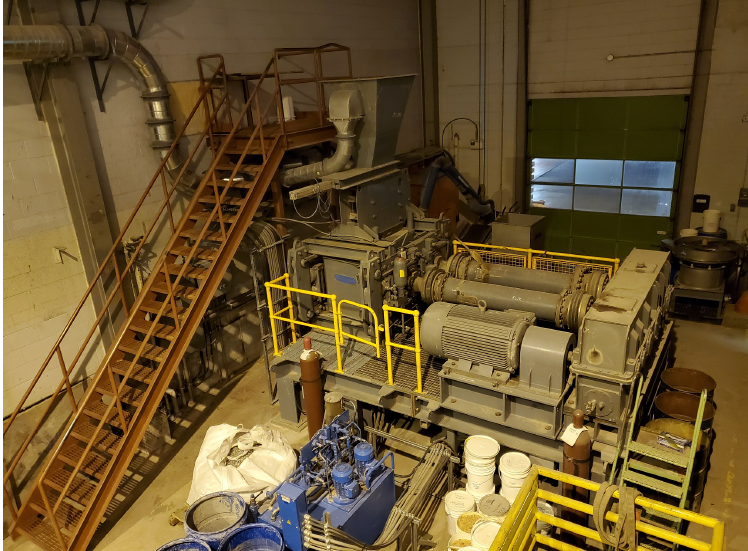
Figure 1. Köppern pilot-scale HPGR at UBC used to run the tests.